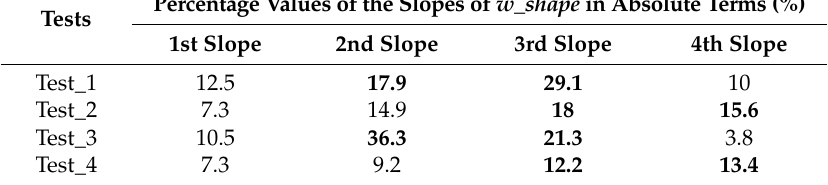
Table 4. Percentage values of the slopes of w_shape in absolute terms. The two highest values are marked in bold and the lowest value is underlined in each test.